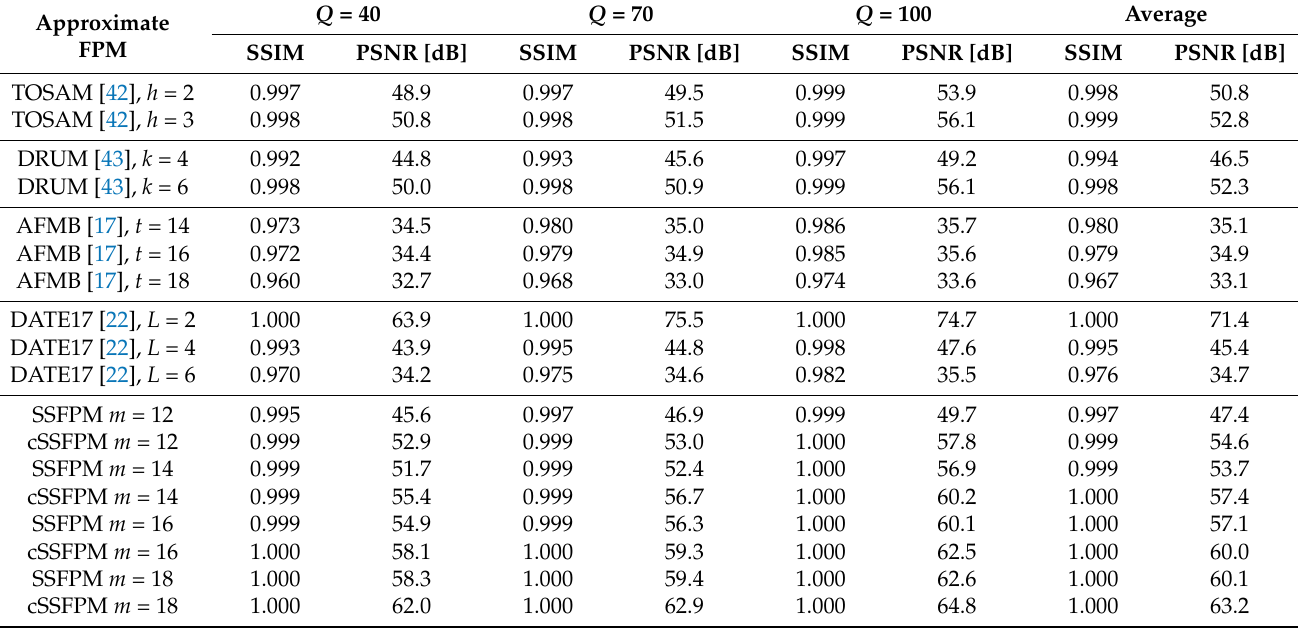
Table 5. Performances of the proposed SSFPM, cSSFPM and the state-of-the-art in the JPEG